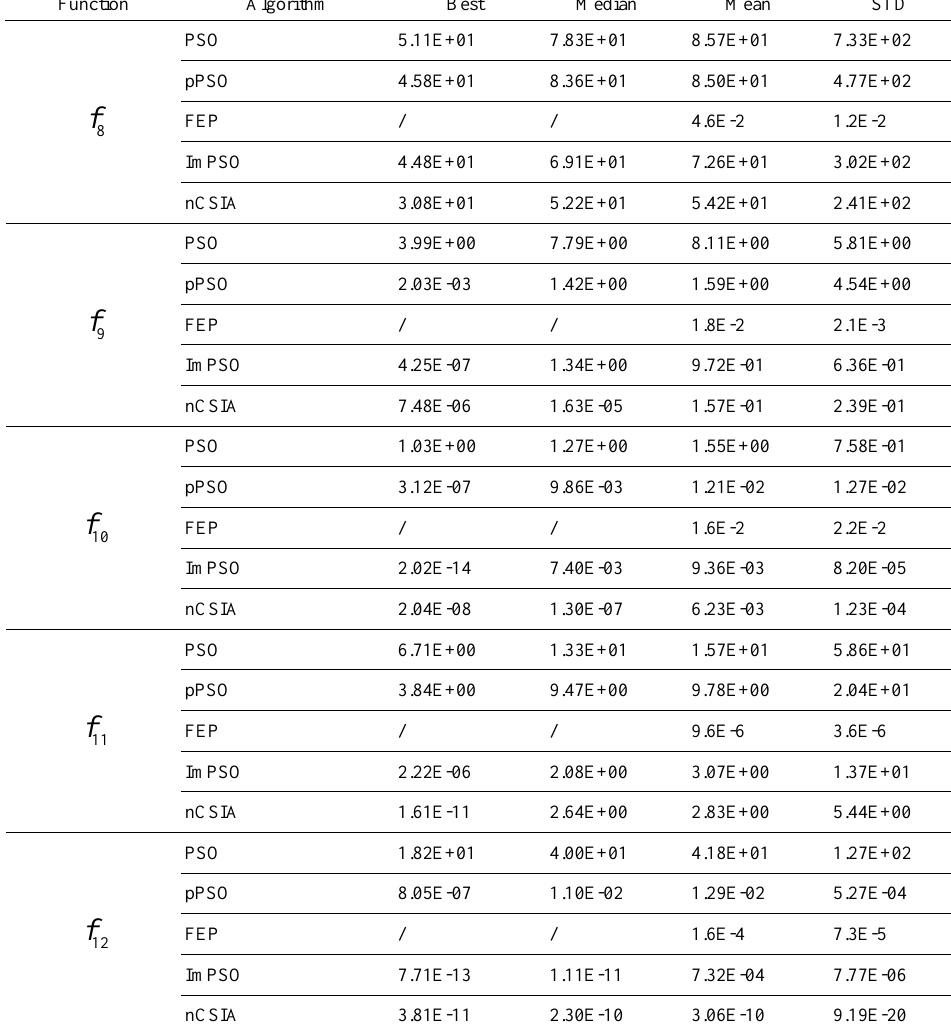
Table 3. Results comparison among PSO, pPSO, FEP, ImPSO, nCSIA for high dimensional multimodal functions. “/” means the item not provided.